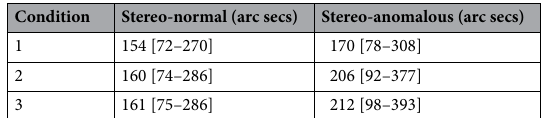
Table 3. DartBoard trial depth error median and interquartile range per condition and group.